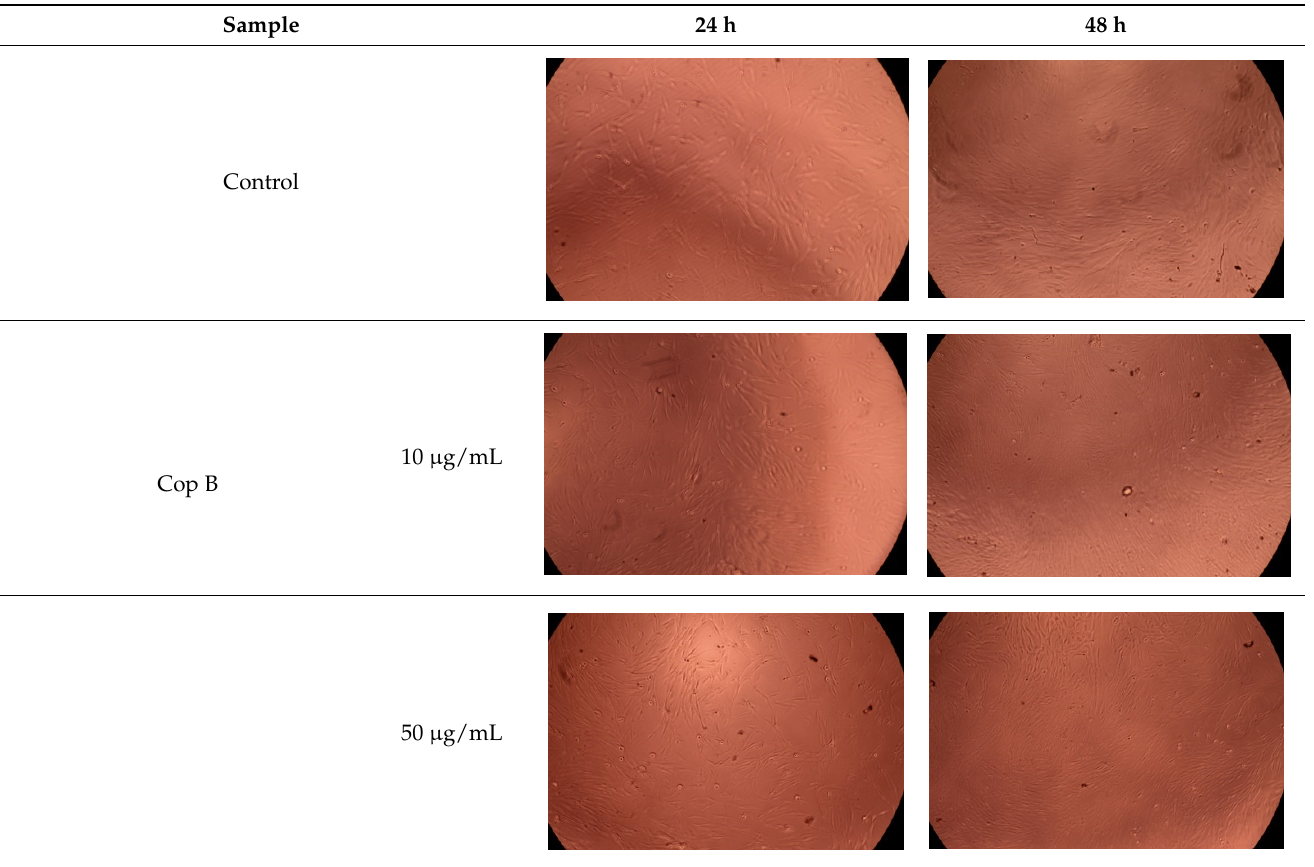
Table 2. Micrographs of fibroblast cells after 24 and 48 h incubation times, respectively. Figure 5. In vitro cell viability of PMs as a function of concentration and time.